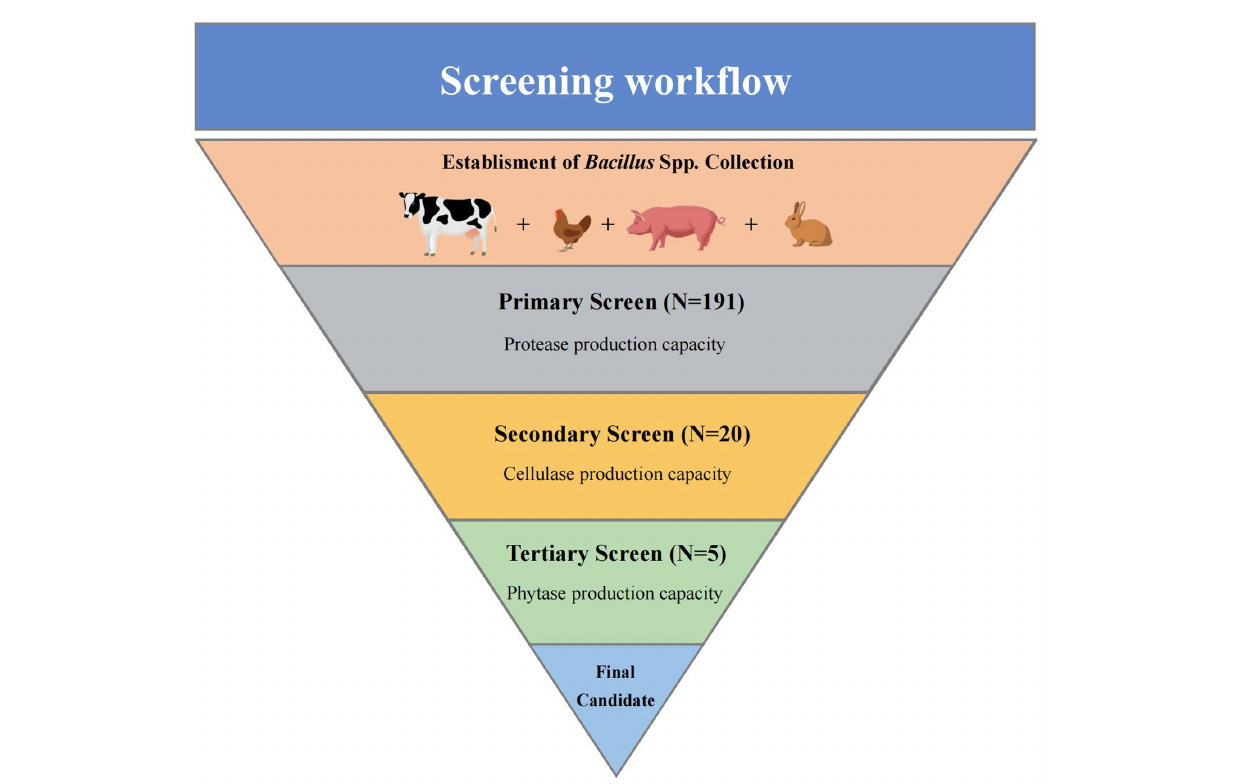
FIGURE 1 Workflow of the screening. The process was divided into three parts and performed to narrow down a total of 191 Bacillus spp. isolates to one strain with the ability to produce multi-enzyme.